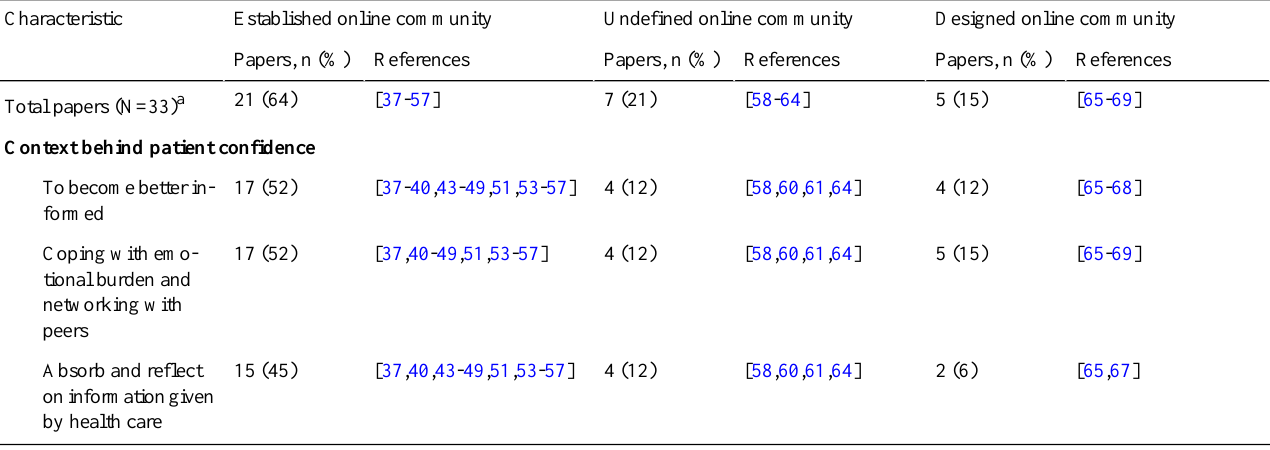
Table 2. The direction of context behind patient confidence in selected references.